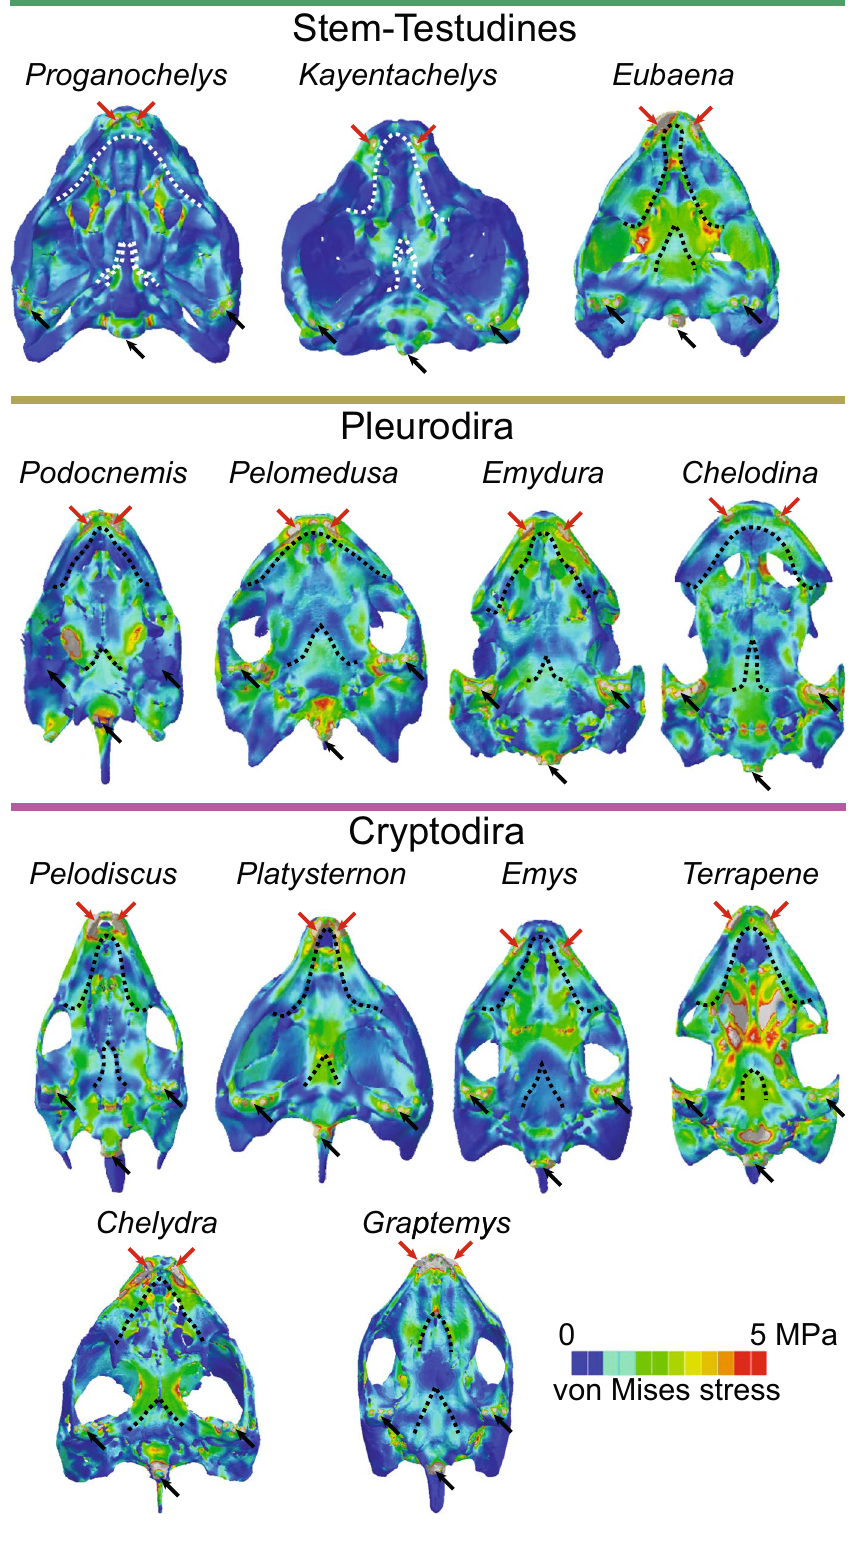
Figure 2. Von Mises stress contour plots of the ventral region of the skull. Contour plots are scaled to the same size and 5 MPa peak stress. Red and black arrows represent the bite and constrained points, respectively. Dotted curves anteriorly and posteriorly, identify the triturating surface and the basipterygoid